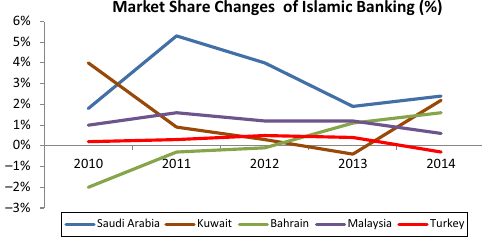
Figure 1. Changes in